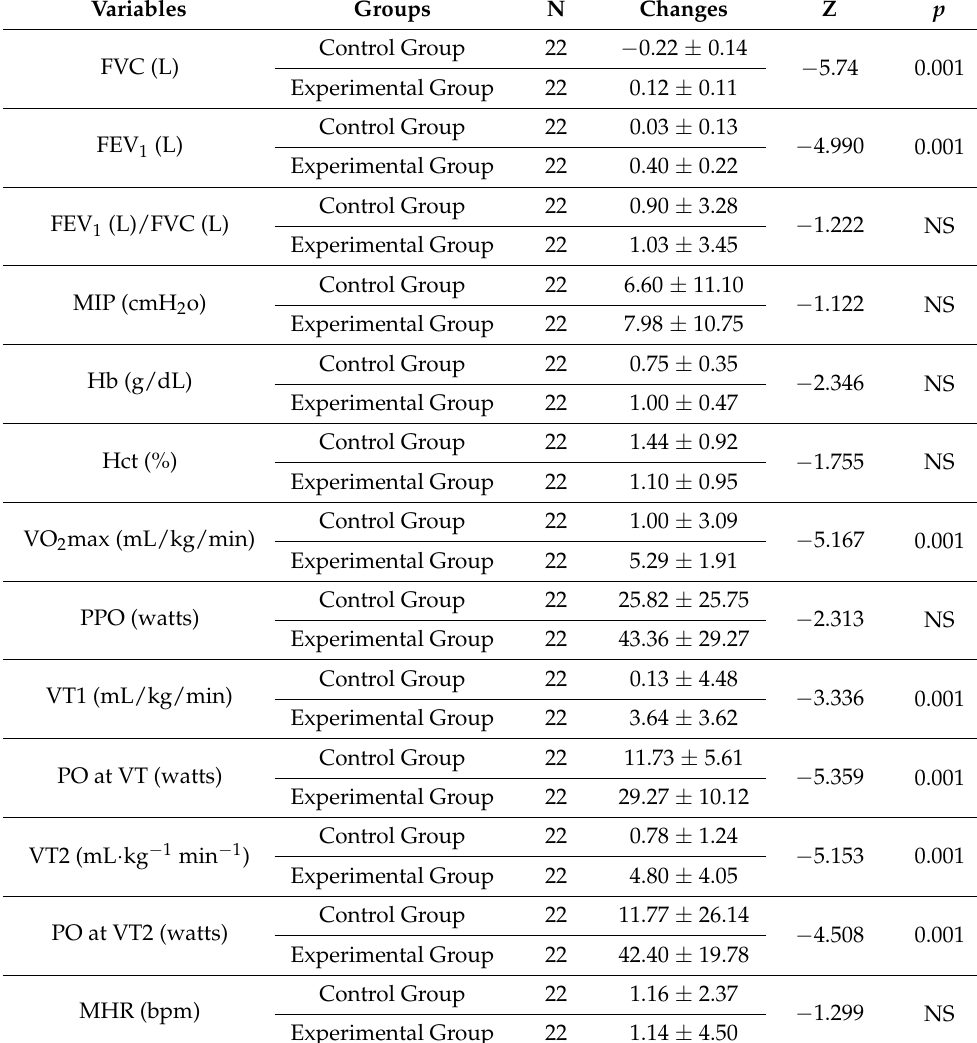
Table 5. Comparison of changes in pulmonary function, hematological data, and biomarkers of cardiorespiratory fitness after eight weeks of high-intensity interval training with (experimental group) or without (control group) use of an elevation